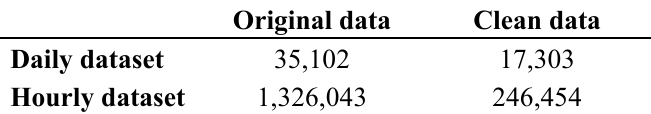
Table 3. The number of original data and clean data.